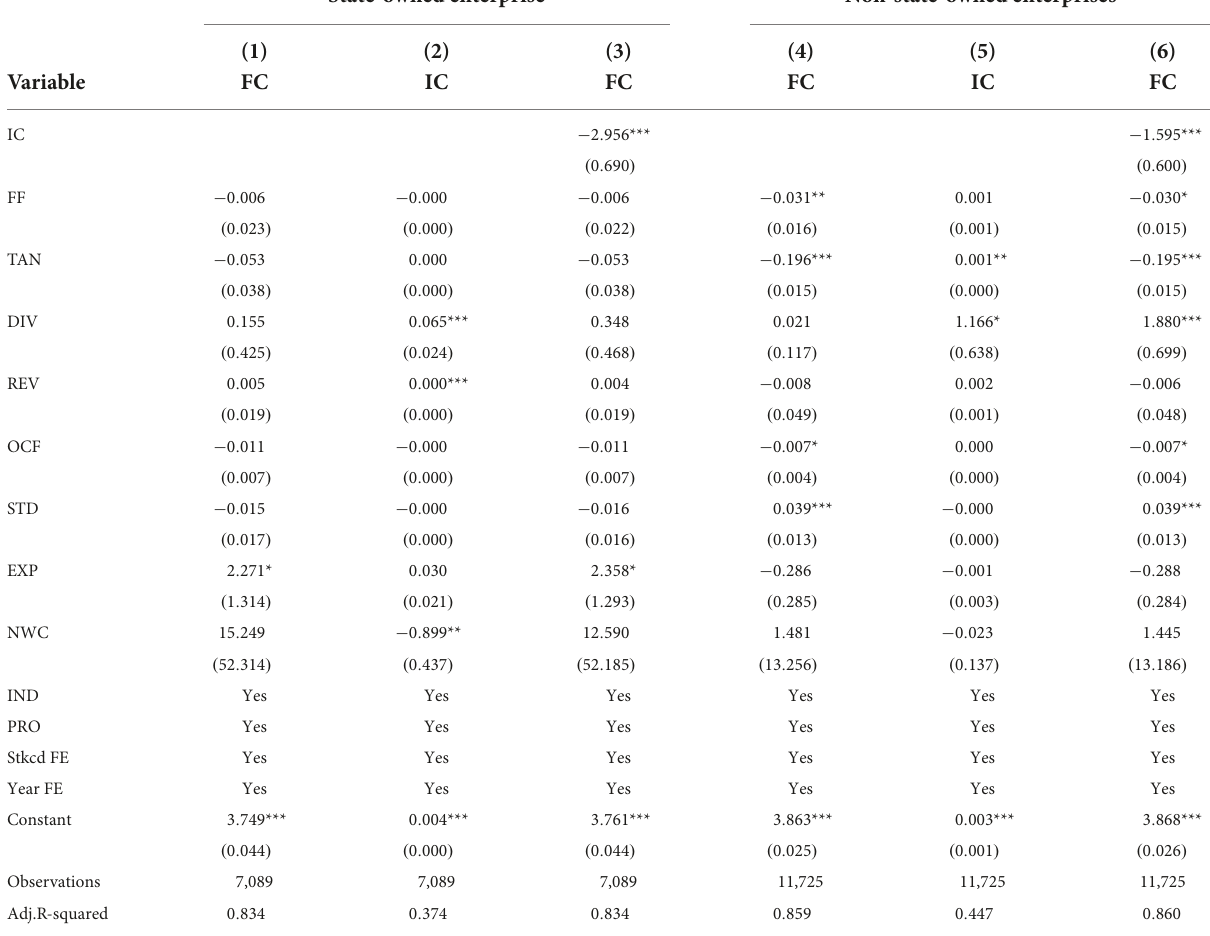
TABLE 7 Financial flexibility and financing constraints: grouped by equity